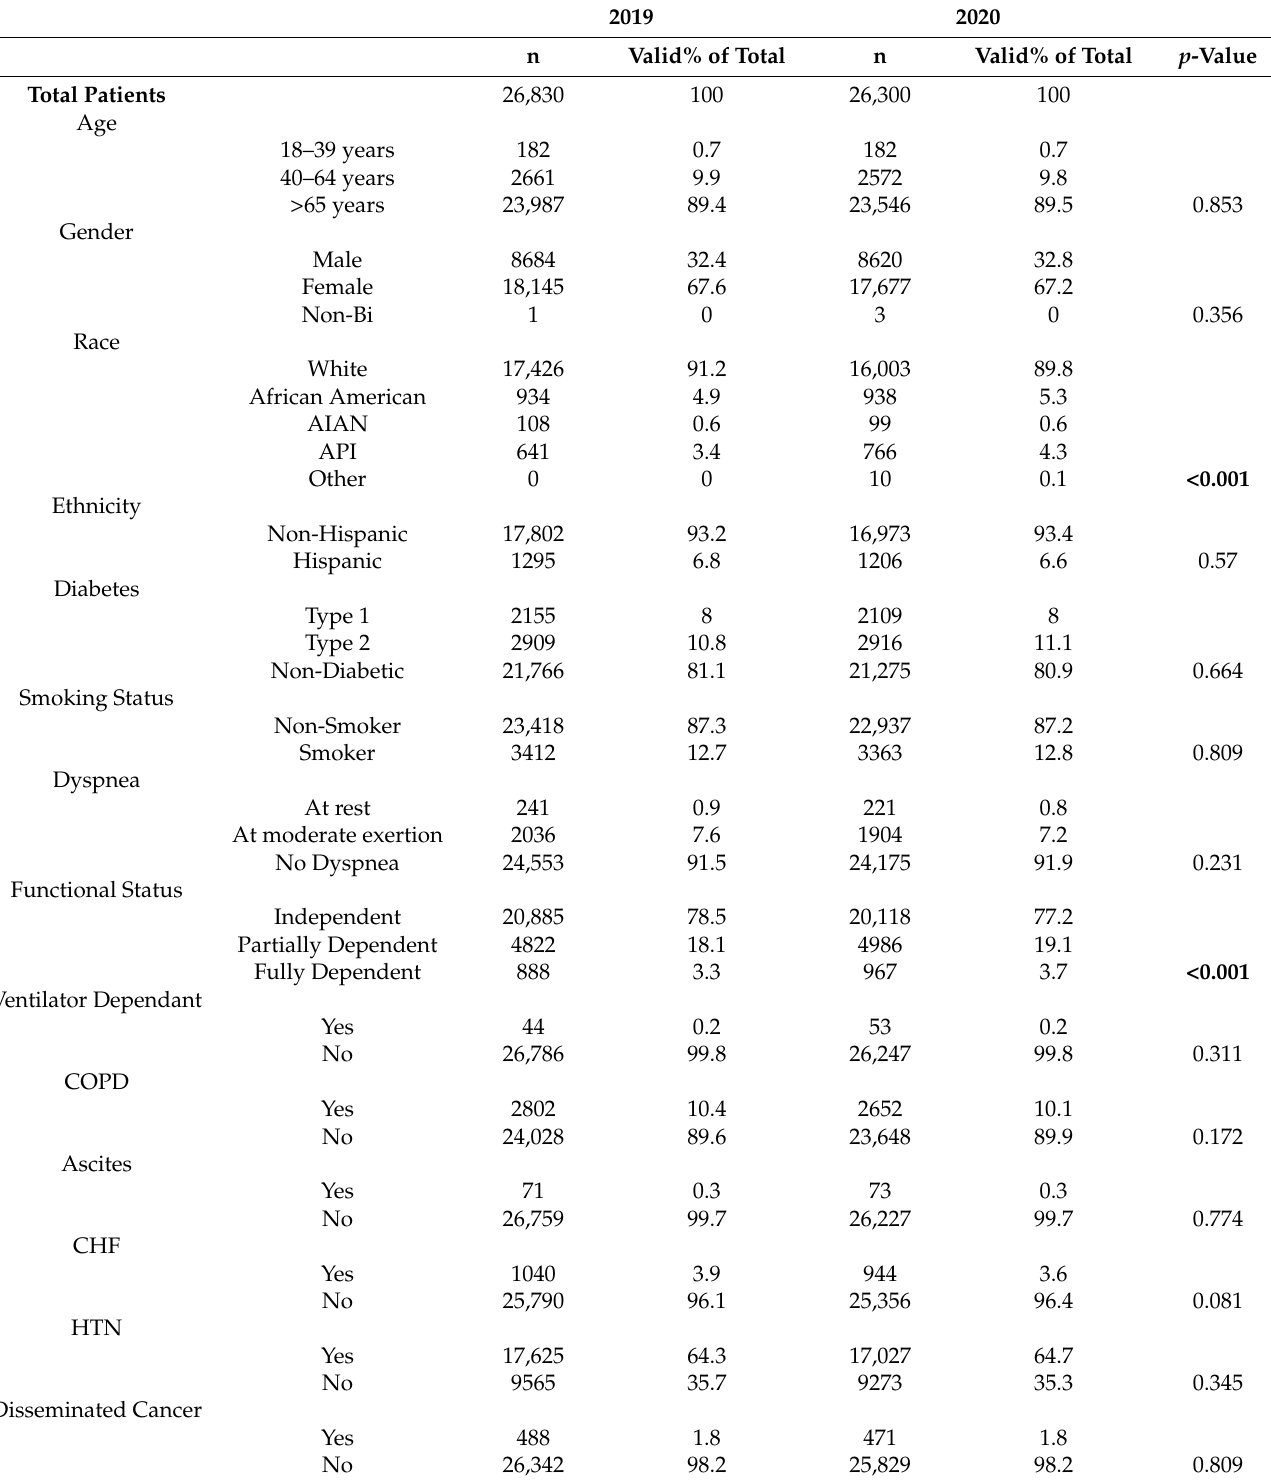
Table 1. Cross Table Year of Diagnosis and Preoperative and Intraoperative Patient Characteristics with Traumatic Proximal Femoral Fractures.